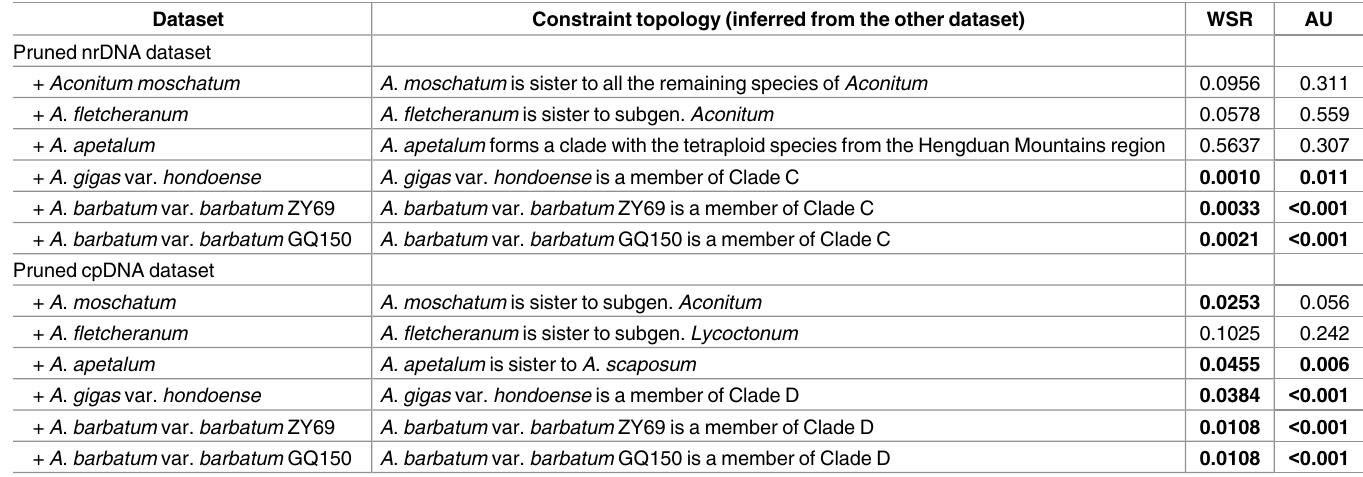
Table 5. P -values of the WSR and AU tests. The pruneddatasets are reconstructed from the originaldatasets by excluding Aconitum apetalum , two acces- sions of A . barbatum var. barbatum (ZY69 and GQ150), A . fletcheranum , A . gigas var. hondoense , and A . moschatum . Bold-facedvalues indicate rejection of the null hypothesiswith 95%